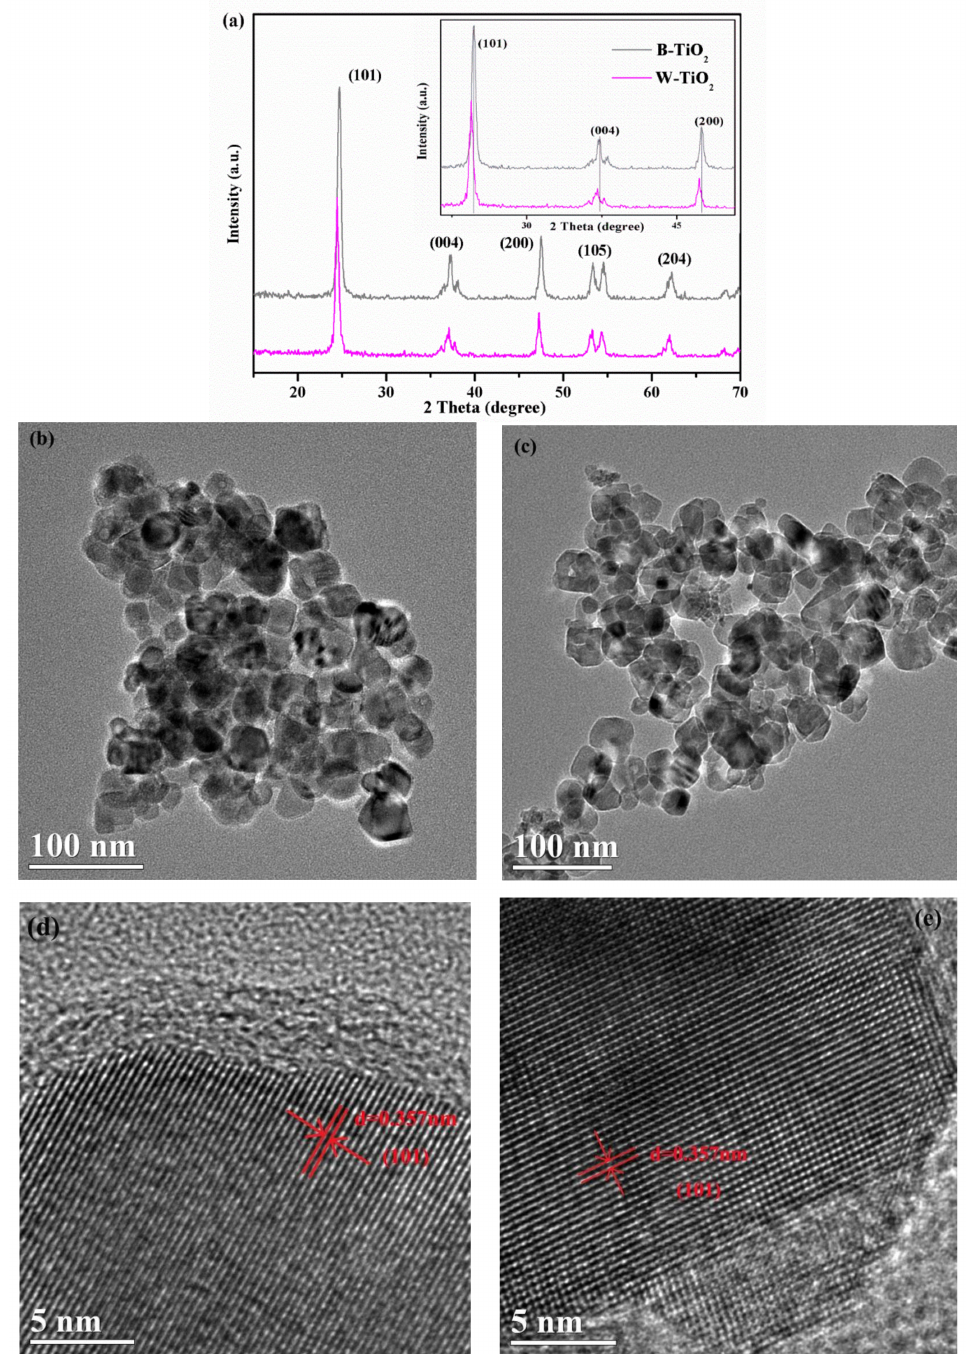
Figure 2. The XRD patterns of the as-prepared samples ( a ); TEM images of TiO 2 nanoparticles before ( b ) W-TiO 2 and after ( c ) B-TiO 2 low temperature annealing; HRTEM images of TiO 2 nanoparticles before ( d ) W-TiO 2 and after ( e ) B-TiO 2 low temperature